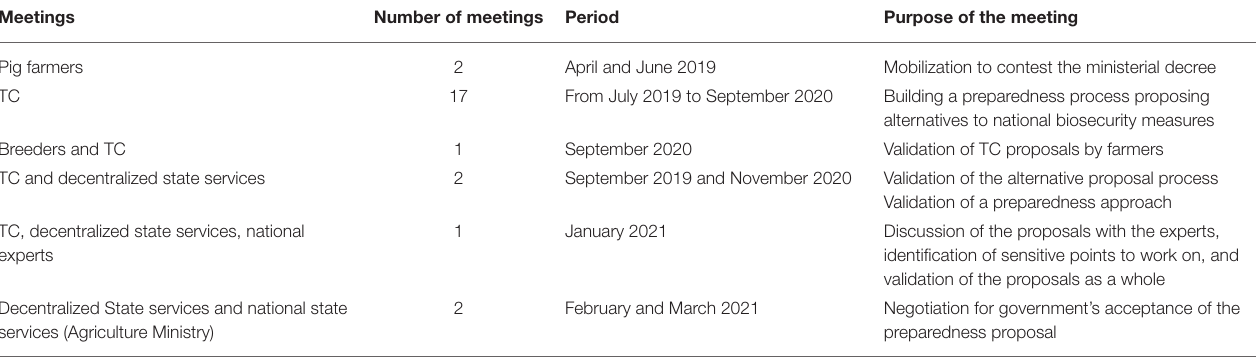
TABLE 1 | Number and purpose of the meetings conducted in the territorial preparedness process against ASF in Corsica